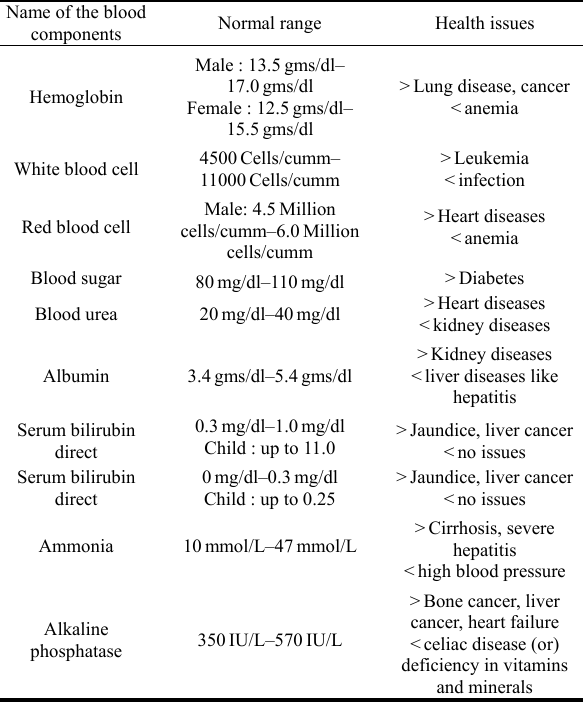
Table 1 Names of the blood components, normal range, and health